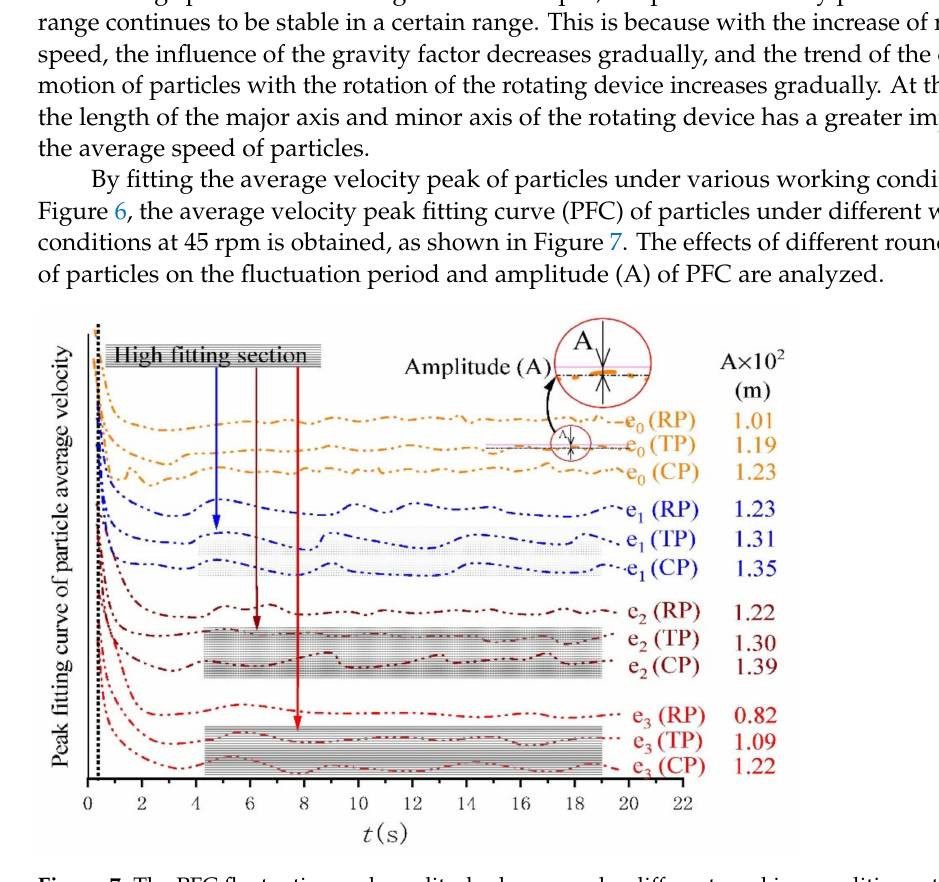
Figure 7. The PFC fluctuation and amplitude change under different working conditions at 45